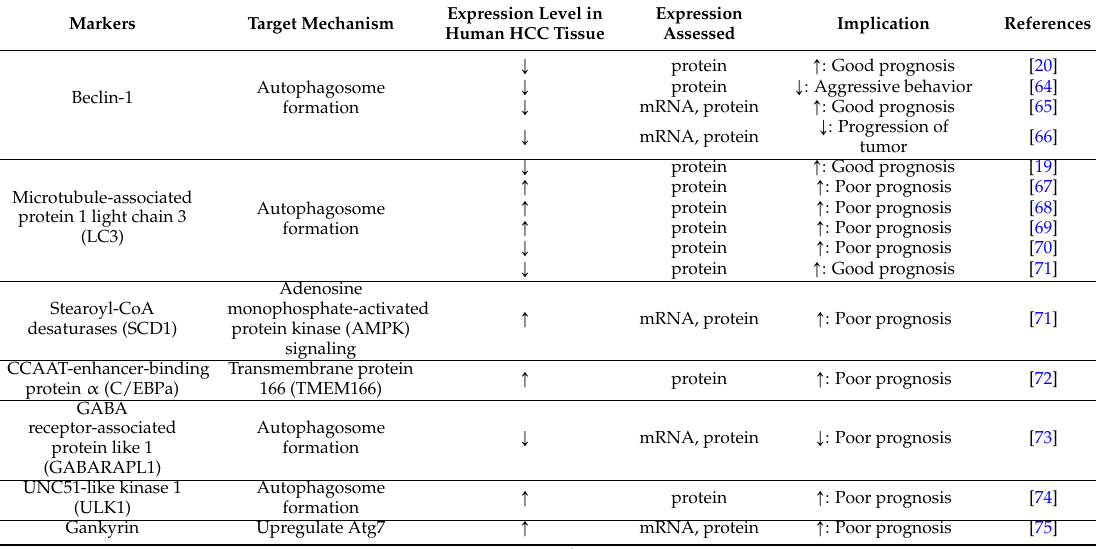
Table 1. Autophagy-related markers predictive for prognosis of hepatocellular carcinoma.